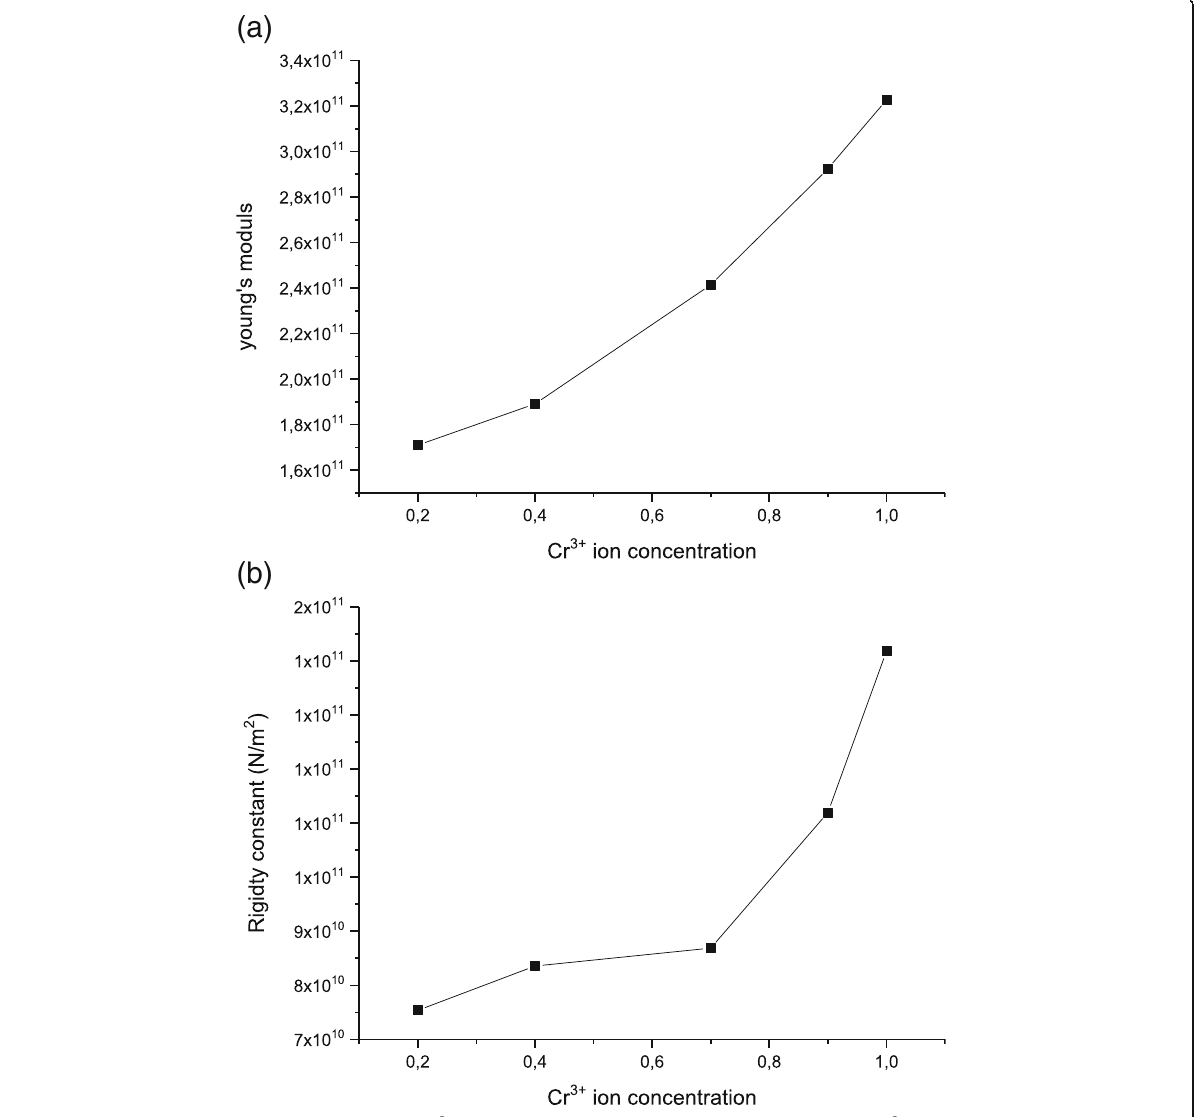
Fig. 2 a Variation of Young ’ s modulus with varying Cr 3+ ion concentration. b Rigidity constant with varying Cr 3+ ion